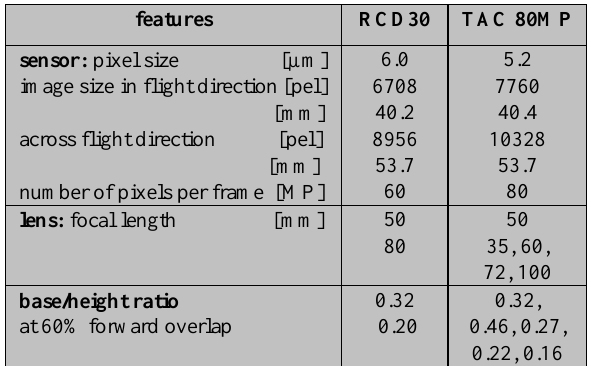
Figure 2. Comparison between large-format and medium-format cameras. At the same FOV and image scale (GSD) the medium- format camera has a much smaller swath